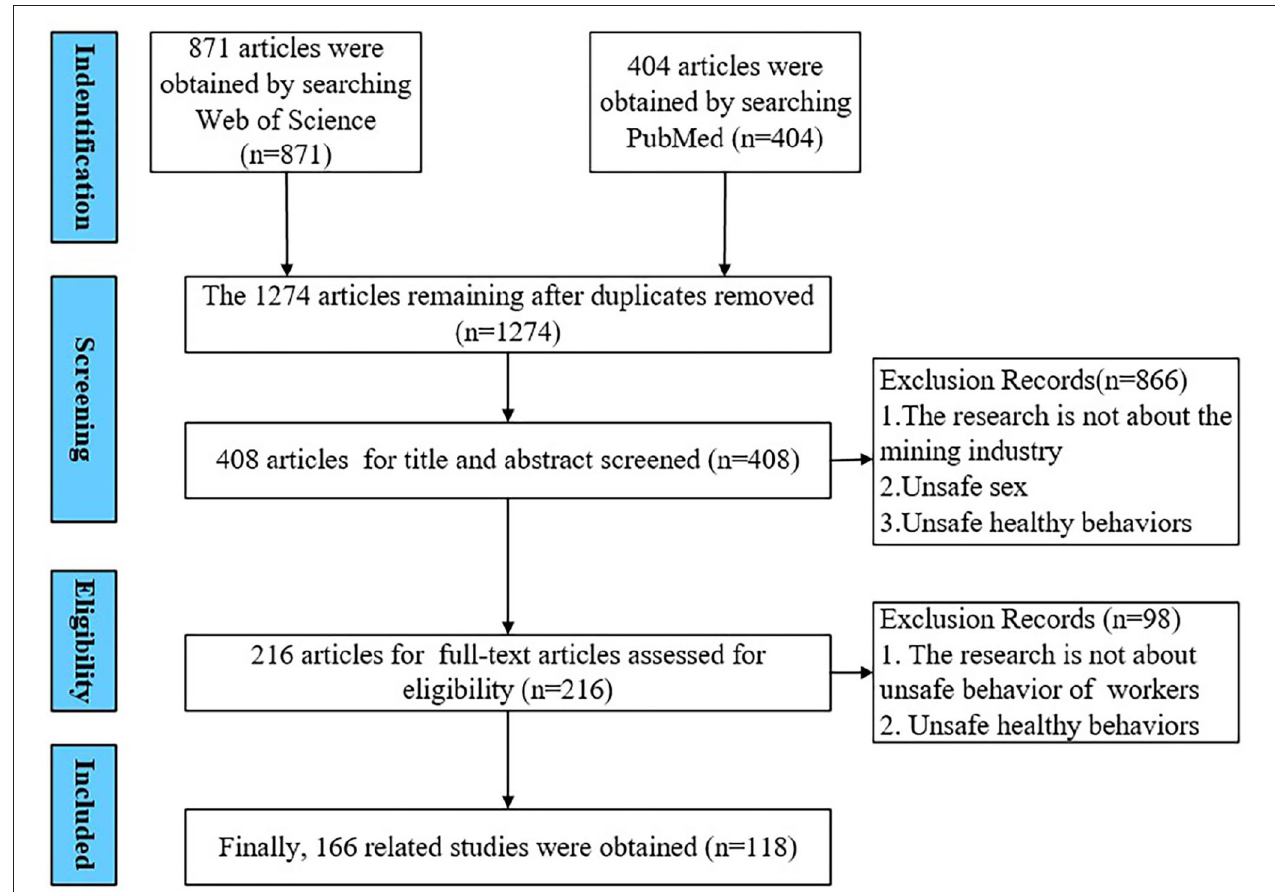
FIGURE 1 | Flowchart of the systematic review process (PRISMA flow